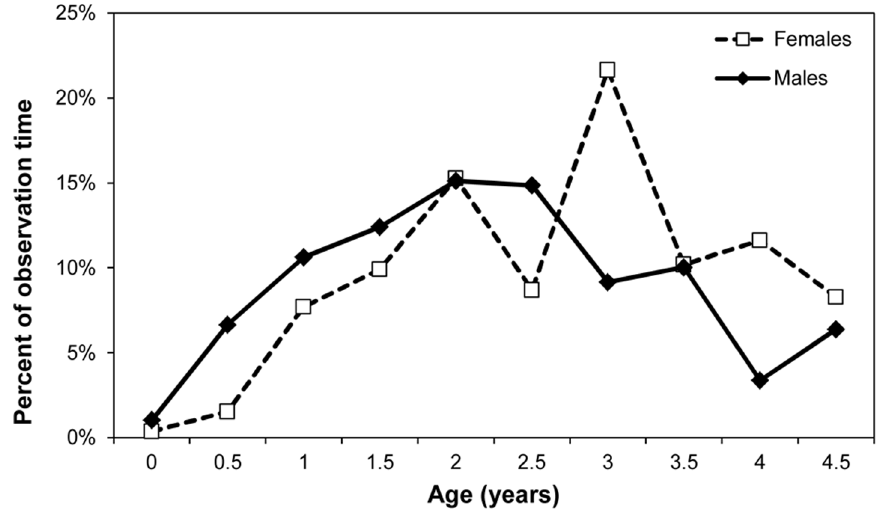
Figure 1. Mean percent of observation time spent in social play for male and female infants.